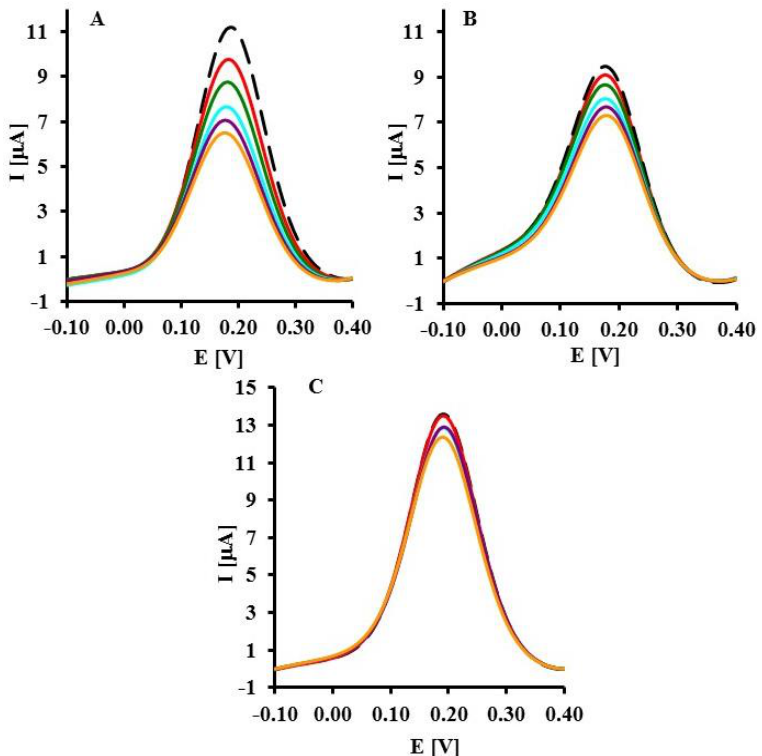
Figure 3. Typical OSWV curves obtained for electrodes modified with GCE-CO-NH-ssDNA-EA upon hybridization with DNA targets. Black curve—before hybridization and the following curves upon hybridization with targets: ( A ) LC, ( B ) SC and ( C ) PC at concentration range: 1–8 [pM]. Solution composition: 1 mM [Fe(CN) 0.1 M PBS (pH = 7.4). The measuring conditions: three electrode configurations: GCE-CO-NH-ssDNA modified electrode, Ag/AgCl reference electrode and Pt counter electrode, frequency 25